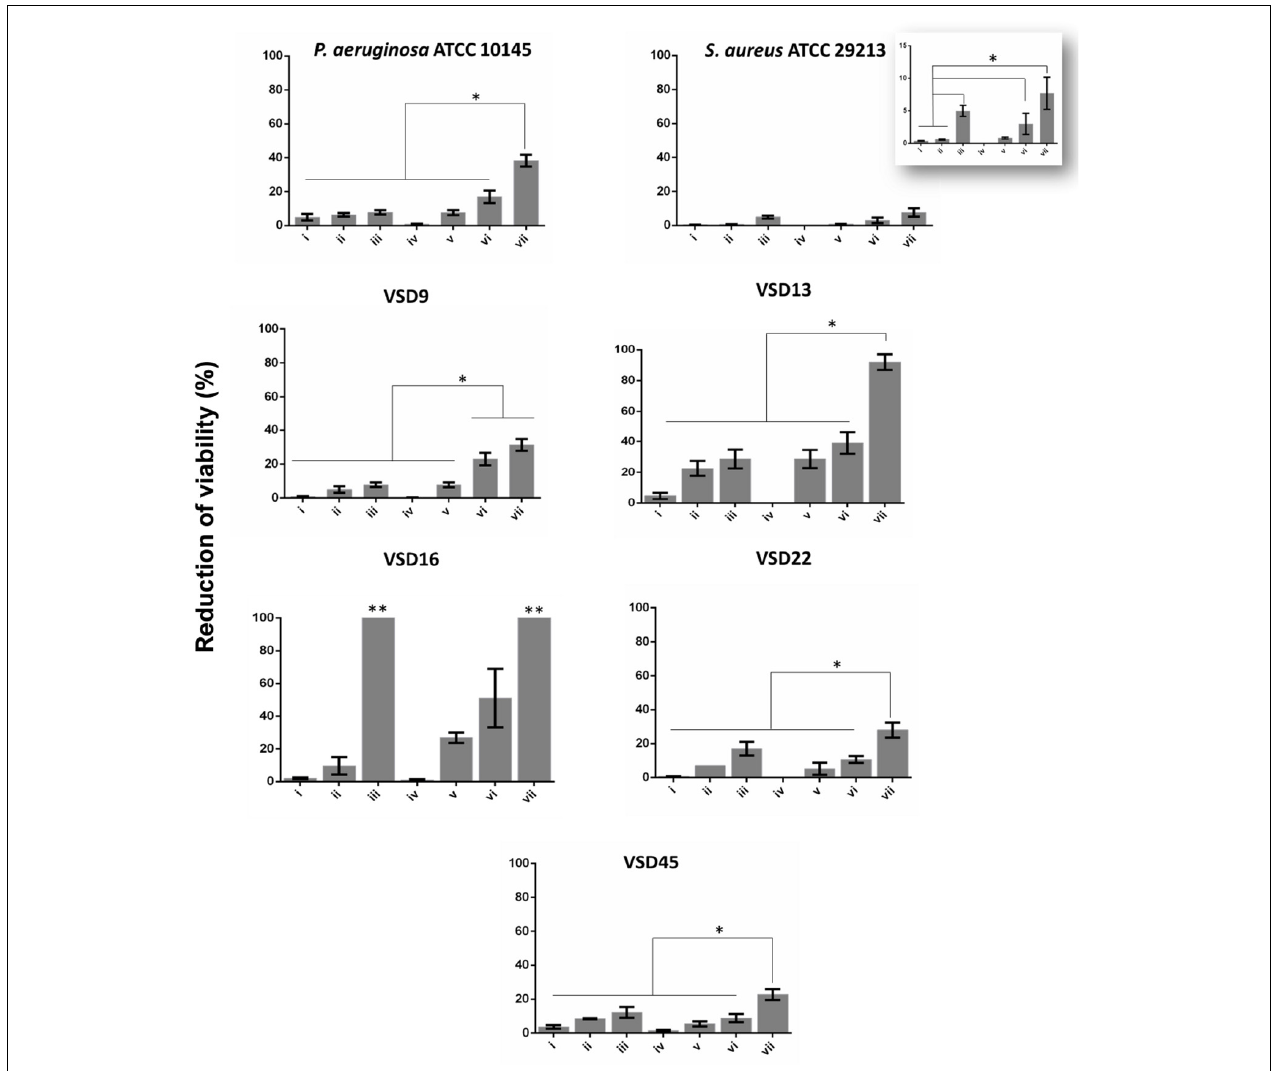
FIGURE 3 | Biofilm destruction (%). (i) AuAgNPs; (ii) ciprofloxacin (CIP); (iii) AuAgNPs + CIP; (iv) visible light irradiation (VLI); (v) AuAgNPs + VLI; (vi) VLI + CIP; (vii) AuAgNPs + VLI + CIP. Nanoparticles were at 10 nM and VLI at 2.02 W cm − 2 . Data represented as the mean ± standard deviation (SD) of three